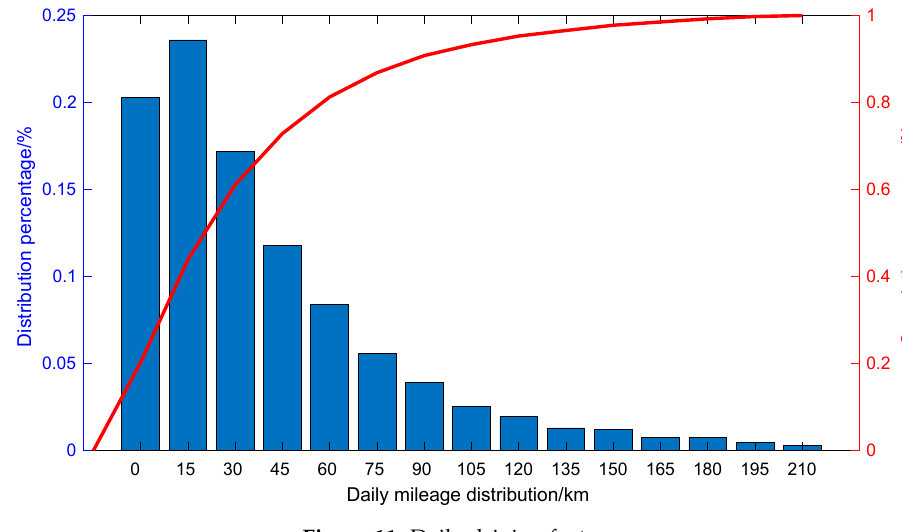
Figure 11. Daily driving features.